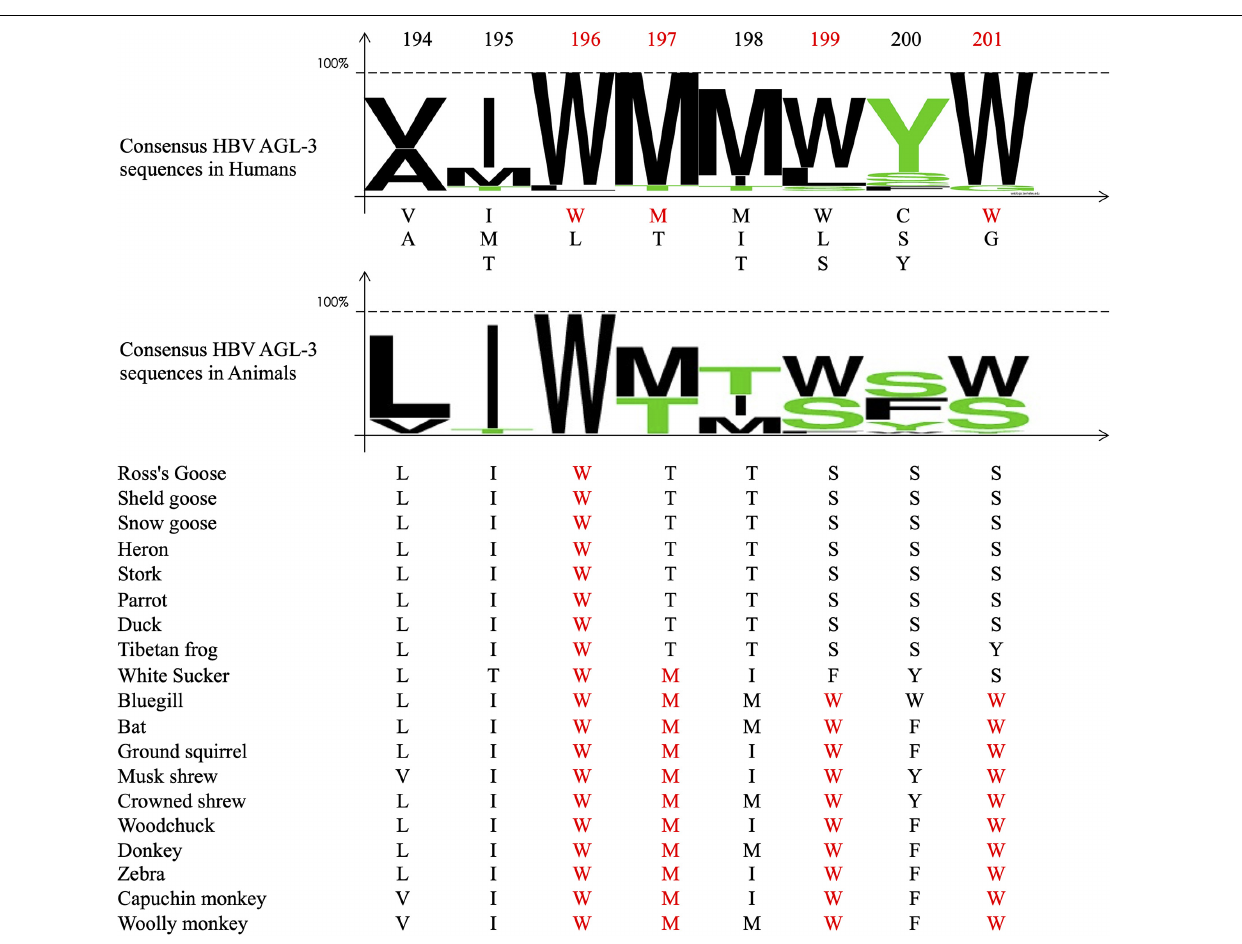
FIGURE 3 | Alignment of the amino-acid sequences of the Delta packaging domain within the C-terminus portion of the large HDV antigen (L-HDAg) protein. On the top of the figure: Amino-acid position. In red the position 196, 197, 199, and 201 of the conserved amino acid in more than 95% of the studied samples (see Table 3 ). The upper panel. Shows the consensus sequence of the aligned HBV amino acid sequences of the HDV matrix domain of the studied samples in humans. The lower panel shows the Web Logo representation and the sequences of the HDV matrix domain of different HBV animal species retrieved from published reference database. In red the conserved amino acids at the positions of interest. Accession numbers of the sequence of the strains used: AB118841; AB118840; HF679404; GU177114; AJ309879; AJ309880; AM183333; AM183330; AM183327; AM183326; AM183331; AX741154; AX741159; AM183328; AM183332; AJ583887; AM183329; AX741164; AX741149; AJ584847; AX741169; X77627; U81989; X60193; M84917; U81988; U19598; AF018077; D01075; X04451; M58629; L22063; L22061; AB037949; AF309420; AF008373; AF008309; AF008375; AF0008319; AF008374; AF008347; AF104263; AY148020;